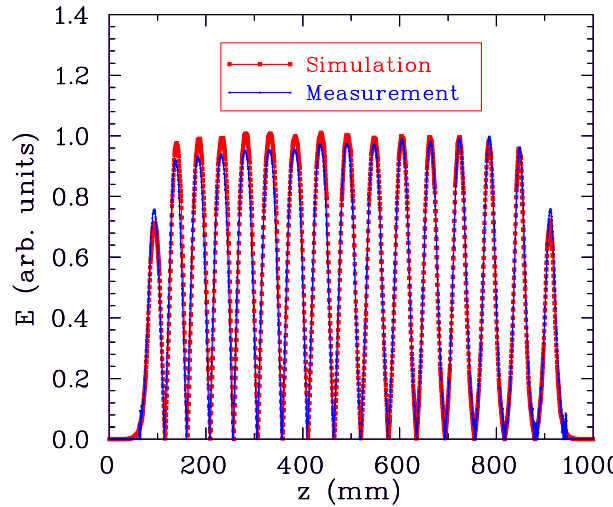
FIG. 12. (Color) Comparison between the measured and the simulated field distribution of the CH-copper model as shown in Fig.